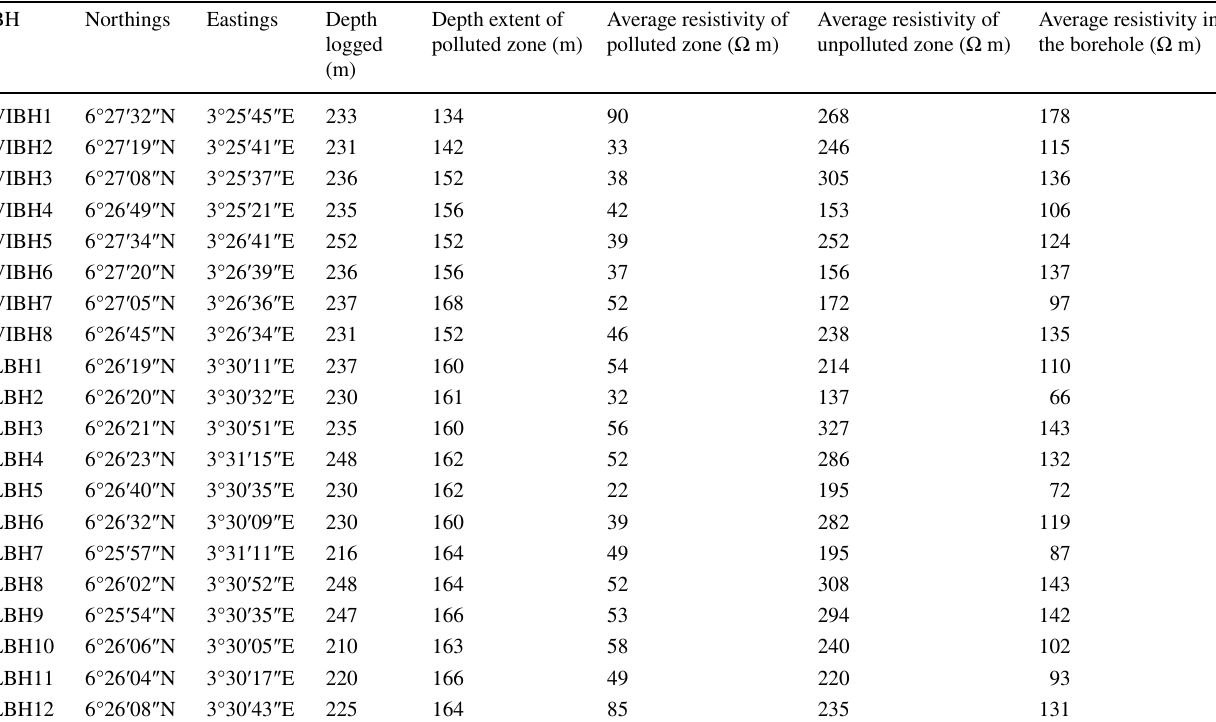
Table 2 Interpretation summary of borehole logs along profiles A–A ′ , B–B ′ , C–C ′ , D–D ′ and E–E ′ BH